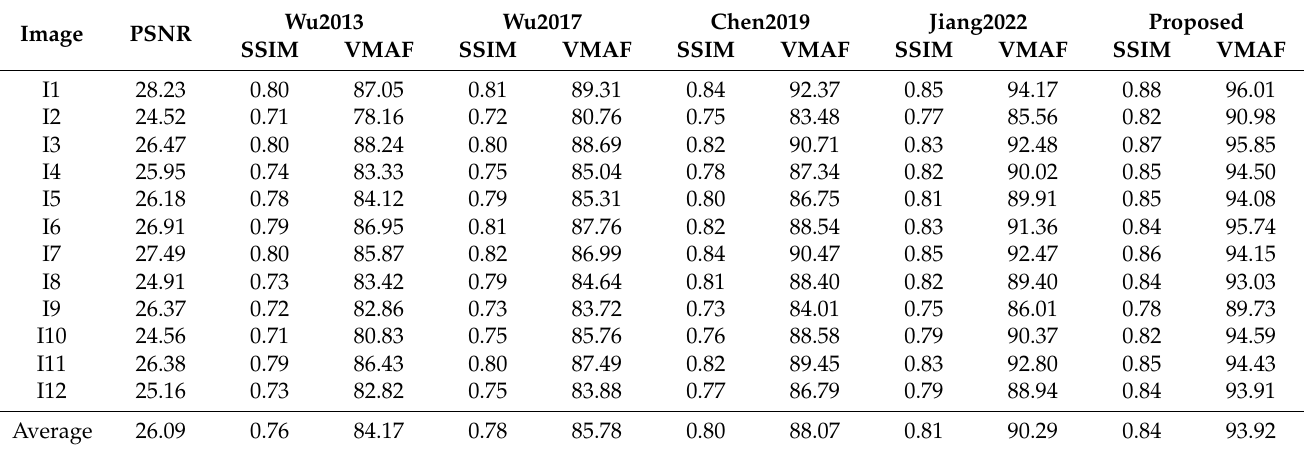
Table 1. Performance comparison results of noise injection based on different JND models.